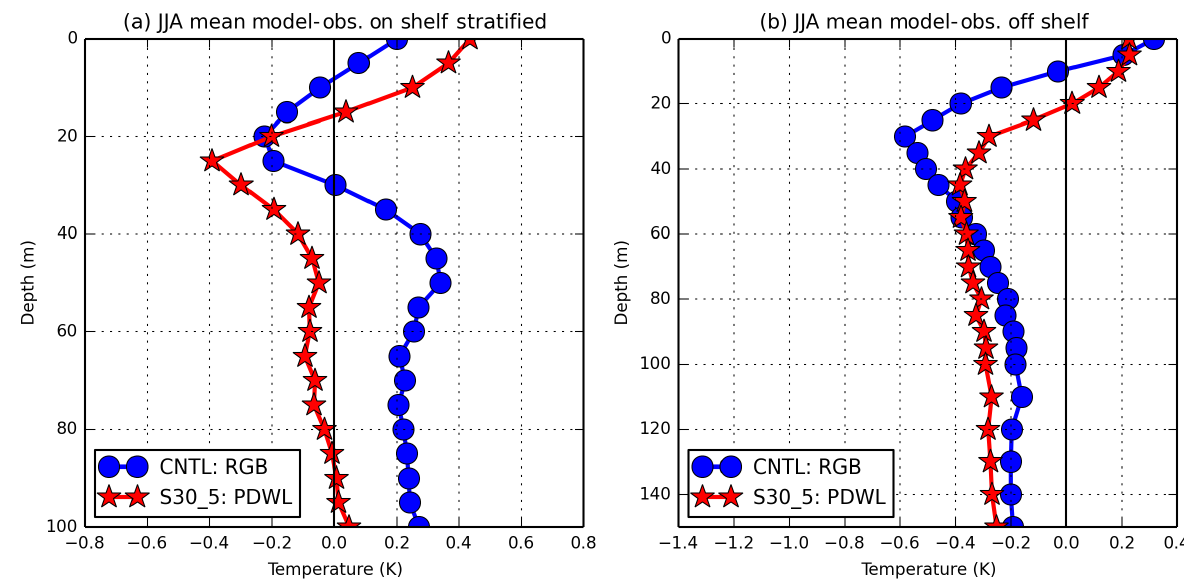
Figure 15. Comparison of summertime profiles compared to NEMO’s three-band light attenuation scheme (RGB) and POLCOMS single- band scheme (PDWL). Panel (a) compares CNTL and S30_5 against the mean of profiles in the seasonally stratified part of the domain on shelf. Panel (b) compares CNTL and S30_5 against the mean of profiles off shelf south of 60 ◦